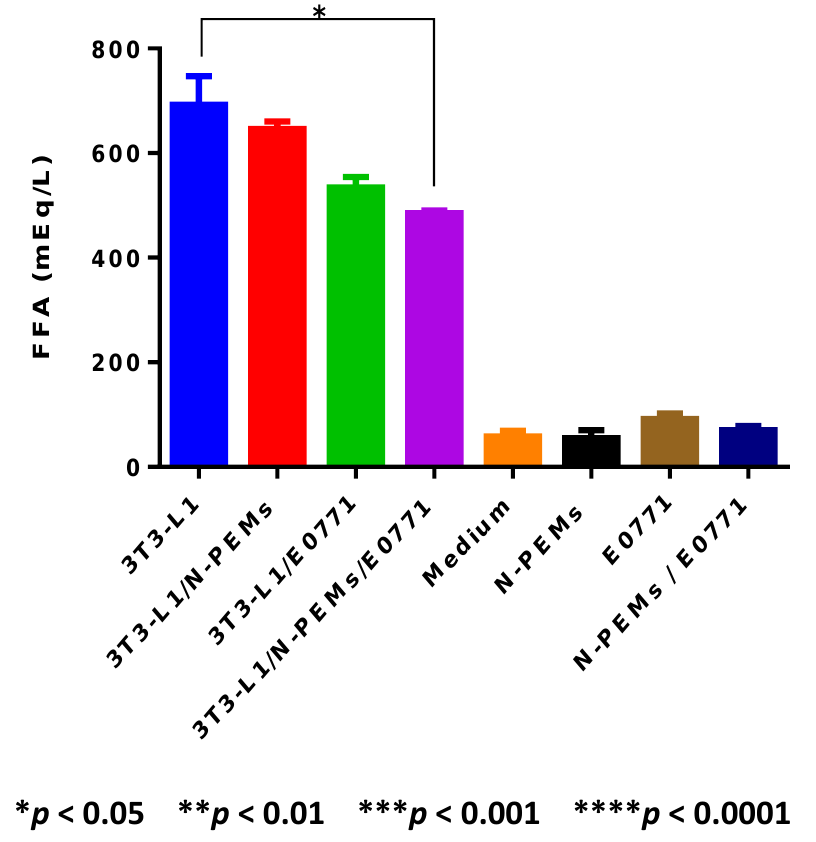
Figure 1. Free fatty acid (FFA) concentration in mammary tumors may be modulated by cells of the mammary tumor microenvironment. Co-culture of adipocytes, macrophages and mammary tumor cells results in reduced amounts of FFA detected in the co-culture cell supernatant, as compared with the amounts released by adipocytes only through lipolysis, as determined by acyl-CoA oxidase-based enzymatic colorimetric methodology in 48 h supernatants from 3T3-L1 murine adipocytes in vitro differentiated for 11 days and co-cultured with macrophages, with mammary tumor cells or with both. Data are representative of one of three independent experiments showing similar results; each sample was tested in